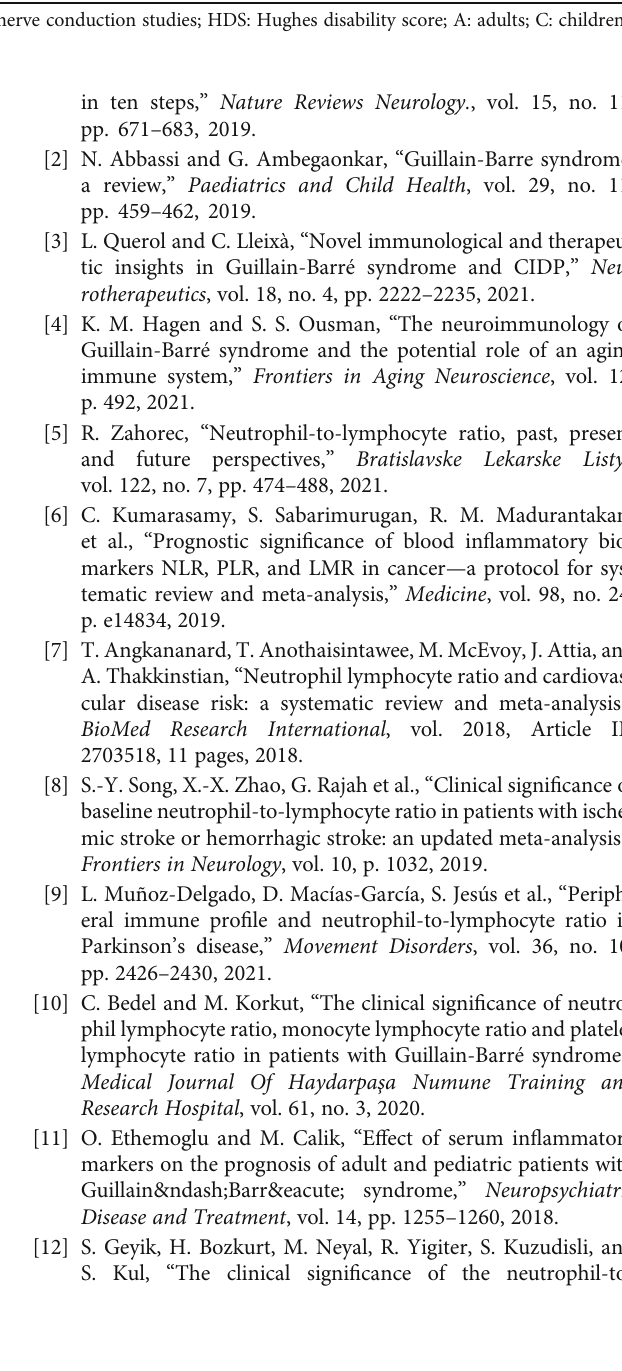
NLR were found to be signi fi cantly higher in GBS patients participating in the study than healthy volunteers. In addition, NLR was positively correlated with the Hughes score and negatively correlated with the MRC sum score calculated at the time of admission and three months after admission. NLR was a predictor of facial diplegia in GBS patients. Also, NLR had a Adults statistically signi fi cant correlation with MRC and NCS fi ndings such as distal latency, main F latency, conduction velocity, and amplitude. NLR was not di ff erent between GBS patients with full recovery and those with Korea Children functional de fi cit after